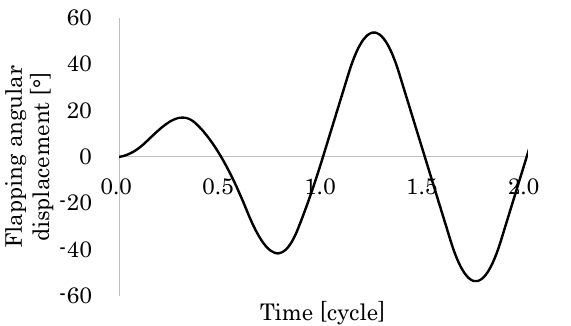
Figure 7. Time histories of the flapping angular displacement. The history during the first one cycle is for the initial transient phase. Table 1. Summary of the model parameters for the insect and dynamically scaled wings.